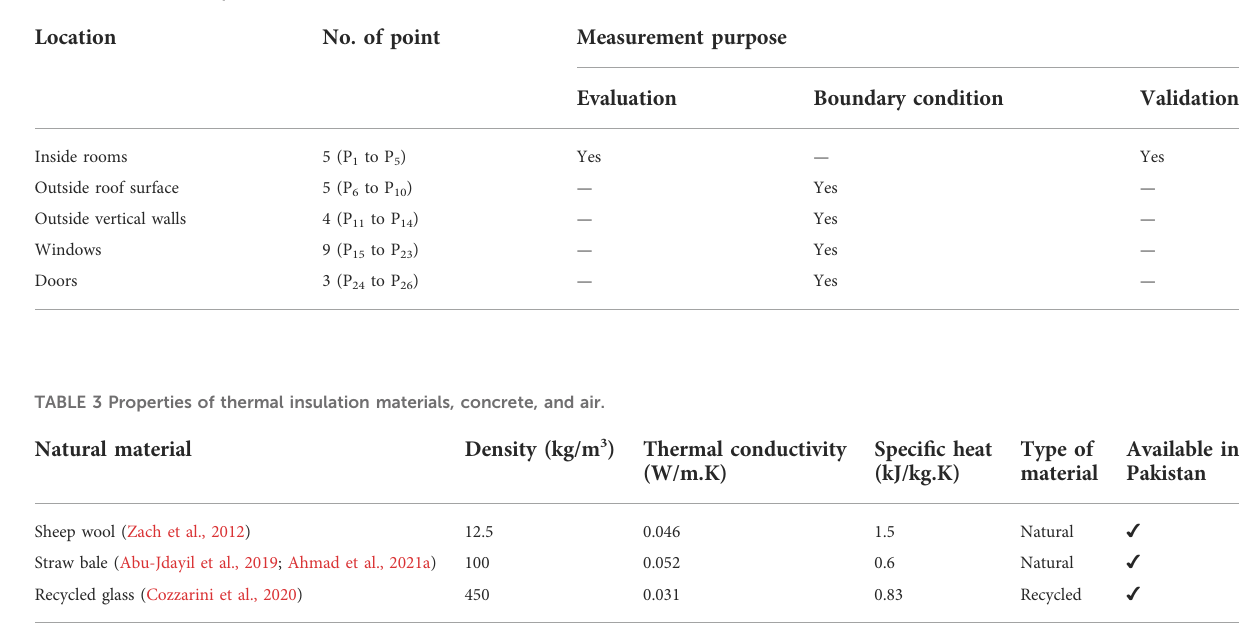
TABLE 2 Location and points of fi eld measurement.